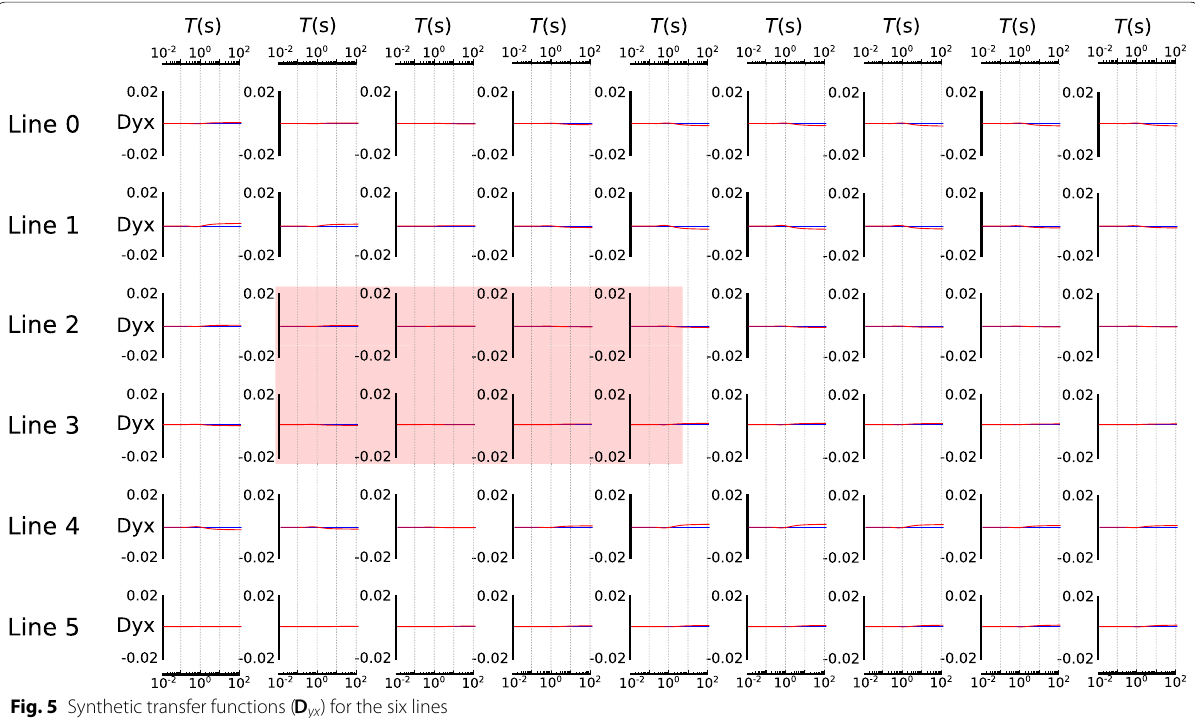
Fig. 5 Synthetic transfer functions ( D yx ) for the six lines